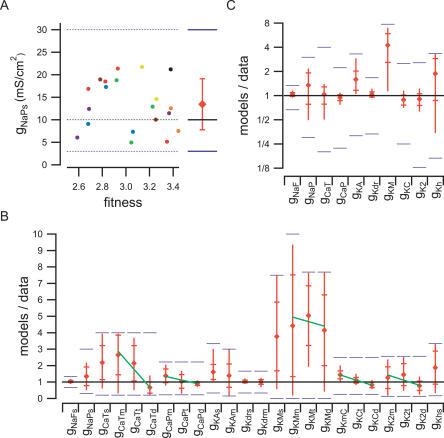
Conductance Spread(A) The fitness of each individual is plotted against its gNaPs value. Points of the same color belong to the same population (see Figure 1E). Blue lines give the range in which channel densities were allowed to vary while the black line gives the value of the data. On the right, the red marker shows the mean ± sdv of the 20 values.(B) For each conductance, the mean value of the 20 selected individuals is shown, normalized to the data. The full red bars delimit the whole range covered by the 20 models while the horizontal red lines give sdv. Blue bars show the range of variation allowed during the search. Green lines are linear fit, supposing regular spacing on the abscissa.(C) Same as (B) for total conductances, obtained by summing conductance densities of the same type, weighted by the surface area of the membrane regions where they apply.